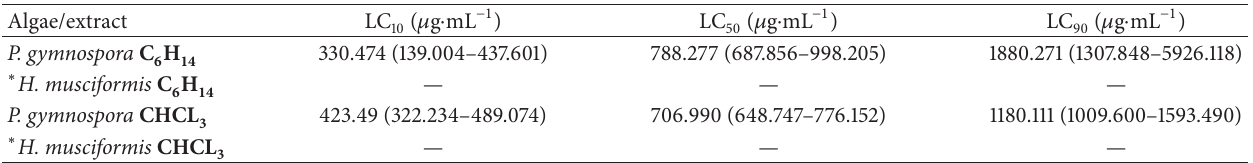
Table 4: More precise toxicity test of the hexane (C beach Riacho Doce, AL, against A.